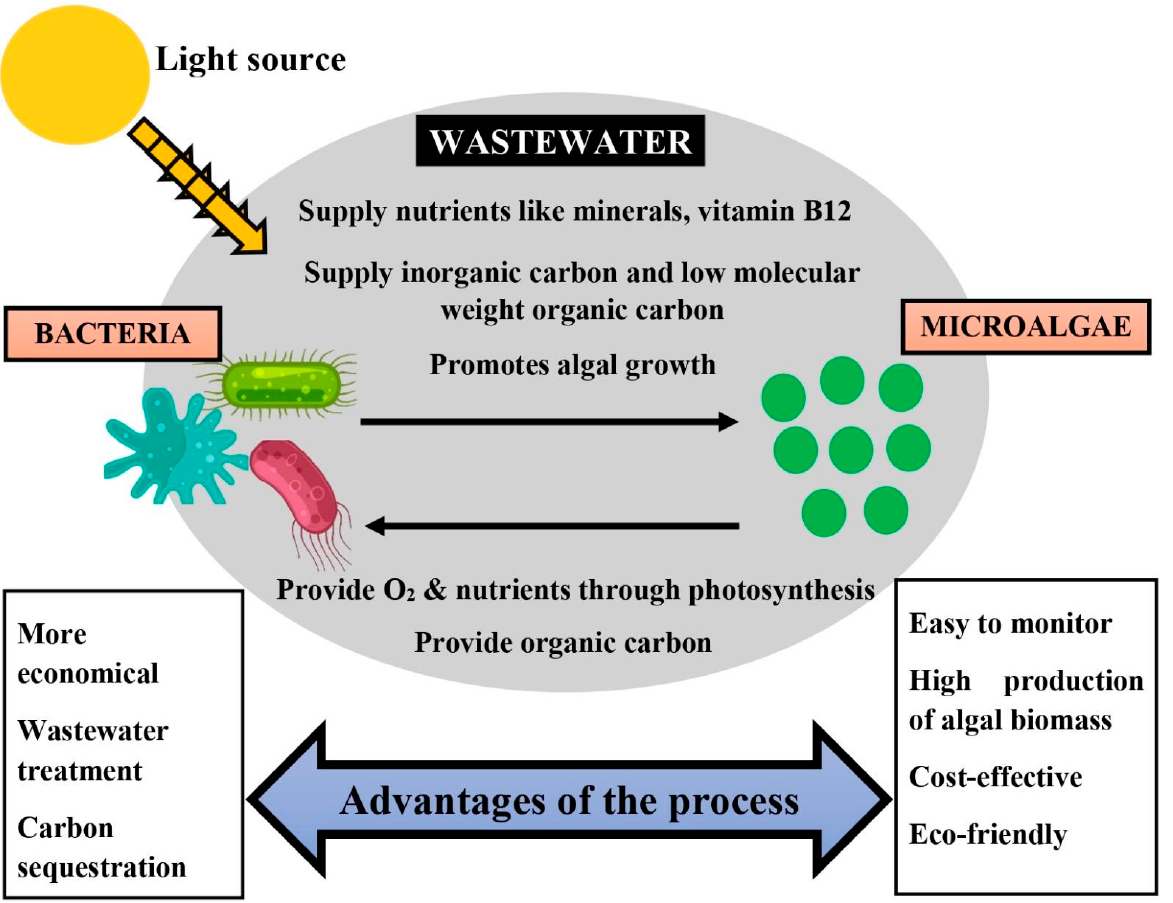
Figure 5. Symbiotic relationship between microalgae and